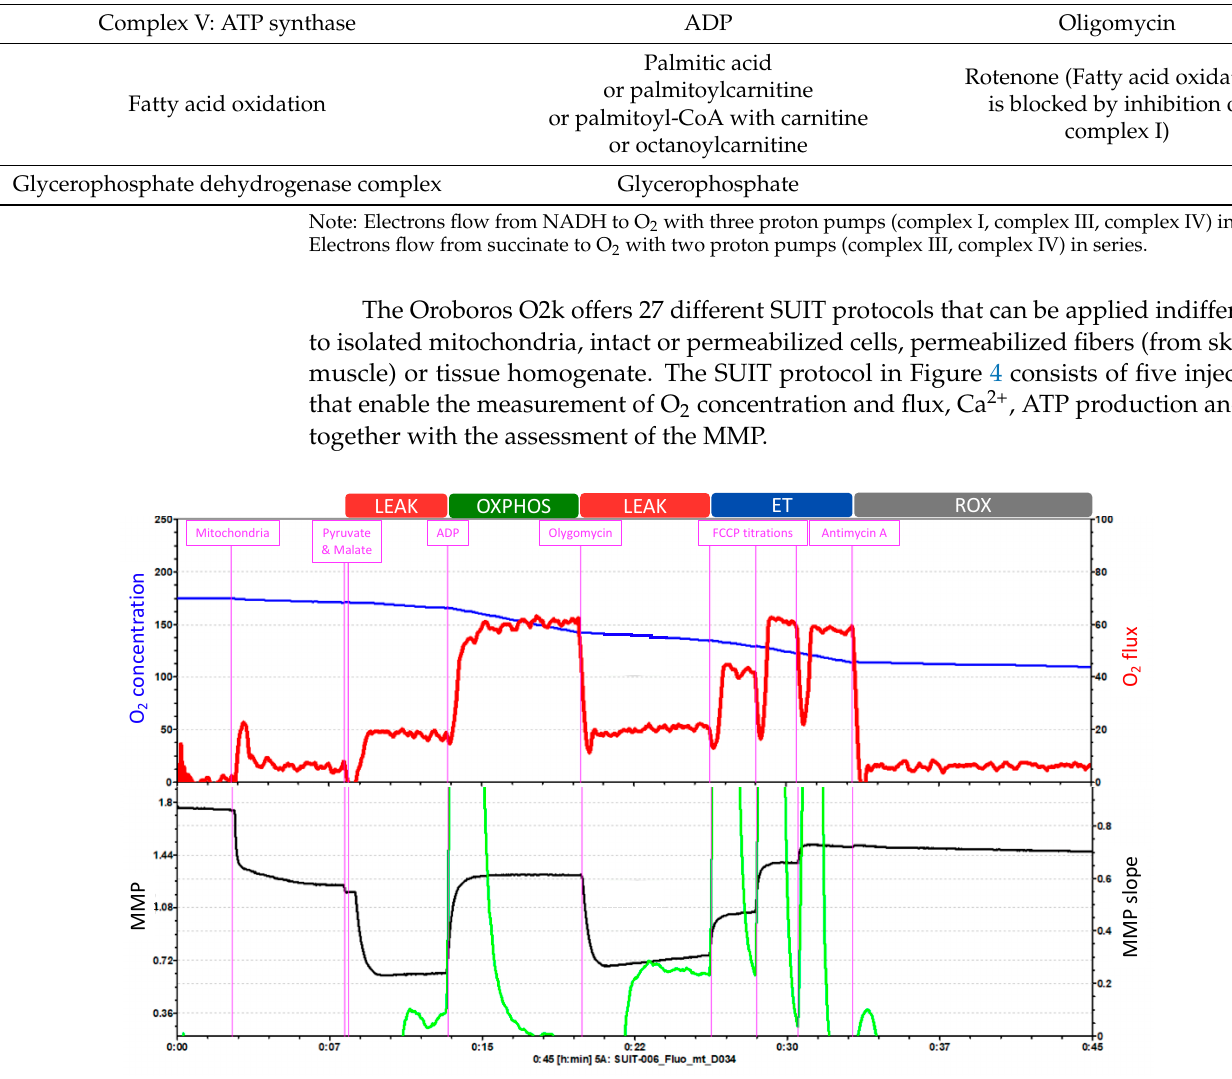
Figure 4. Example of a SUIT protocol pattern on isolated mitochondria. O 2 concentration and O 2 flux and MMP measured with TMRM. Adapted from Oroboros O2k. O 2 concentration is shown in blue (left Y -axis) and O 2 flux is represented in red (right Y -axis) as a function of time. The “O 2 concentration” parameter represents the amount of oxygen within the chamber, and the “O 2 flux” parameter accounts for the O 2 consumption.